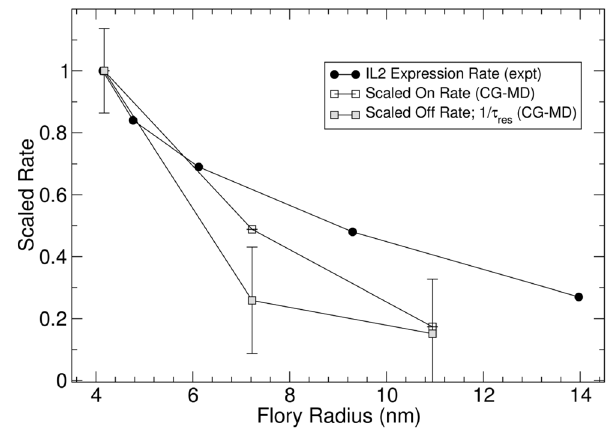
Figure 5. The impact of polymer length on pMHC-TCR binding kinetics based on CG-MD simulation. The on-rates and off-rates derived from the simulation for the PEG 4000, PEG 10000 and PEG 20000 were scaled against the data for the PEG 4000 and plotted as a function of the polymer Flory radius. To display the relationship between binding rates and TCR triggering efficiency, the experimentally determined IL2 expression rates for PEG 3500, PEG 5000, PEG 7500, PEG 150000 and PEG 30000 shown in Fig. 4A were scaled against PEG 3500 and plotted as a function of the polymer Flory radius.